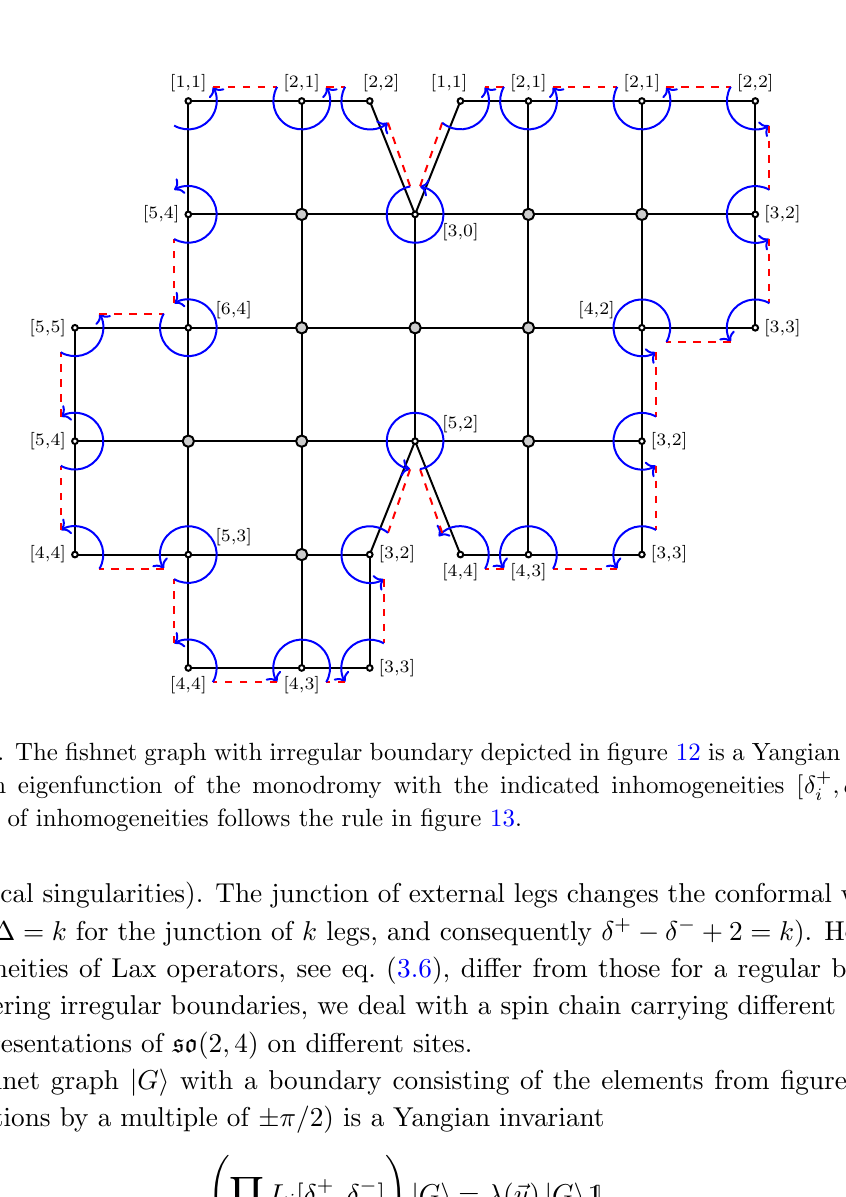
; (cid:14) (cid:0) ]. The i i